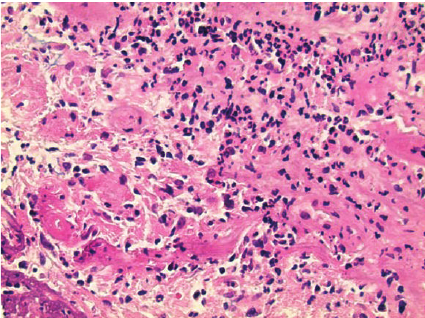
Figure 8: Brain biopsy of the ring enhancing lesion showing exudative inflammation consistent with an abscess (Hematoxylin and Eosin stain, magnification ×